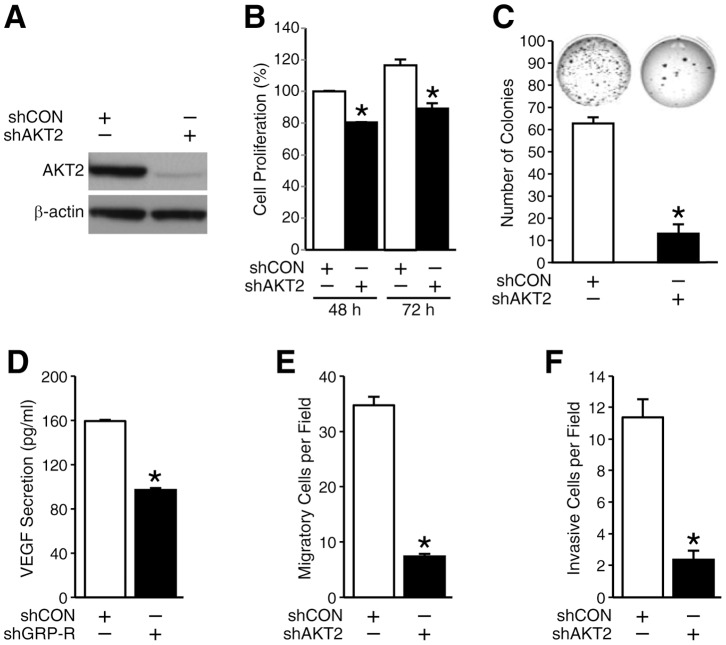
AKT2 regulated the tumorigenic potential of neuroblastoma cells in vitro.(A) AKT2 expression was measured in BE(2)-C/shCON and BE(2)-C/shAKT2 cells by Western blotting and consistent knockdown of AKT2 was confirmed. (B) BE(2)-C/shCON and shAKT2 cells were replated at 1×104 cells per well in 96-well plates and cell proliferation was measured after culturing for 48 and 72 h. (C) Anchorage-independent growth was assessed by soft agar colony assay in BE(2)-C/shCON and shAKT2 cells. Cells were plated in soft agar (2×103 cells/well) for 3 weeks and then photographed after staining with 0.005% of crystal violet. Colony growth was significantly inhibited in the cells treated with shAKT2. Bar graph represents the quantitative assessment of colony growth. (D) VEGF secretion was measured in BE(2)-C/shCON and shAKT2 cells. Cells (3×105 cells/well) were plated in 6-well plate and cultured for 24 h, then the supernatants were collected for VEGF secretion by ELISA. (E) The number of migratory cell decreased in AKT2 silenced cells. BE(2)-C/shCON and shAKT2 cells plated in collagen type I-coated transwell plates and incubated for 6 h, the migrated cells were fixed and stained with DAPI and counted. (F) The number of invasive cell decreased in AKT2 silenced cells. BE(2)-C/shCON and shAKT2 cells plated in Matrigel coated transwells and incubated for 48 h. The invasive cells were fixed and stained with DAPI and counted. Data represent mean ± SEM.; * = p<0.05 vs. shCON.